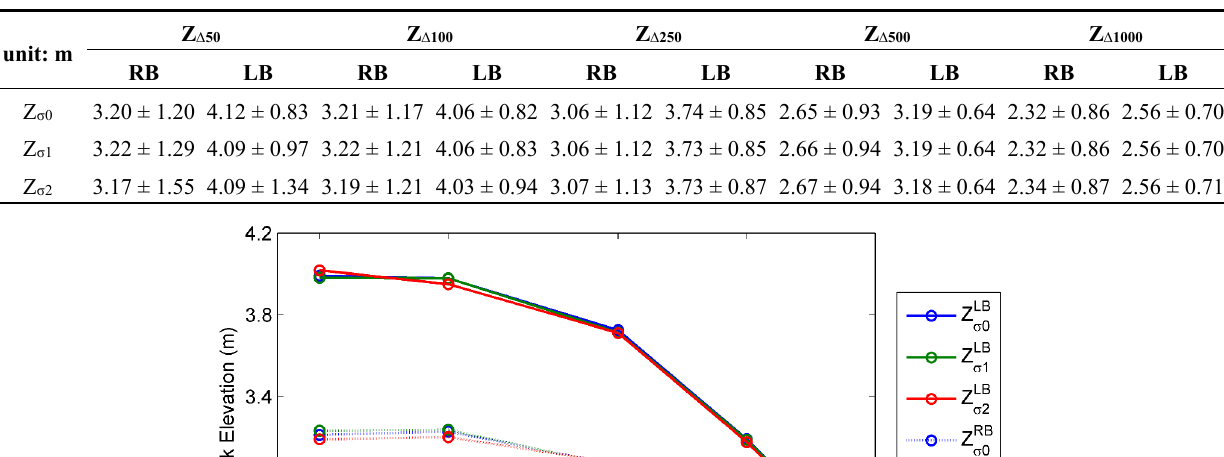
Table 2. The mean plus or minus standard deviation of both the left (LB) and right bank (RB) elevations in terms of grid-box size and DEM error.